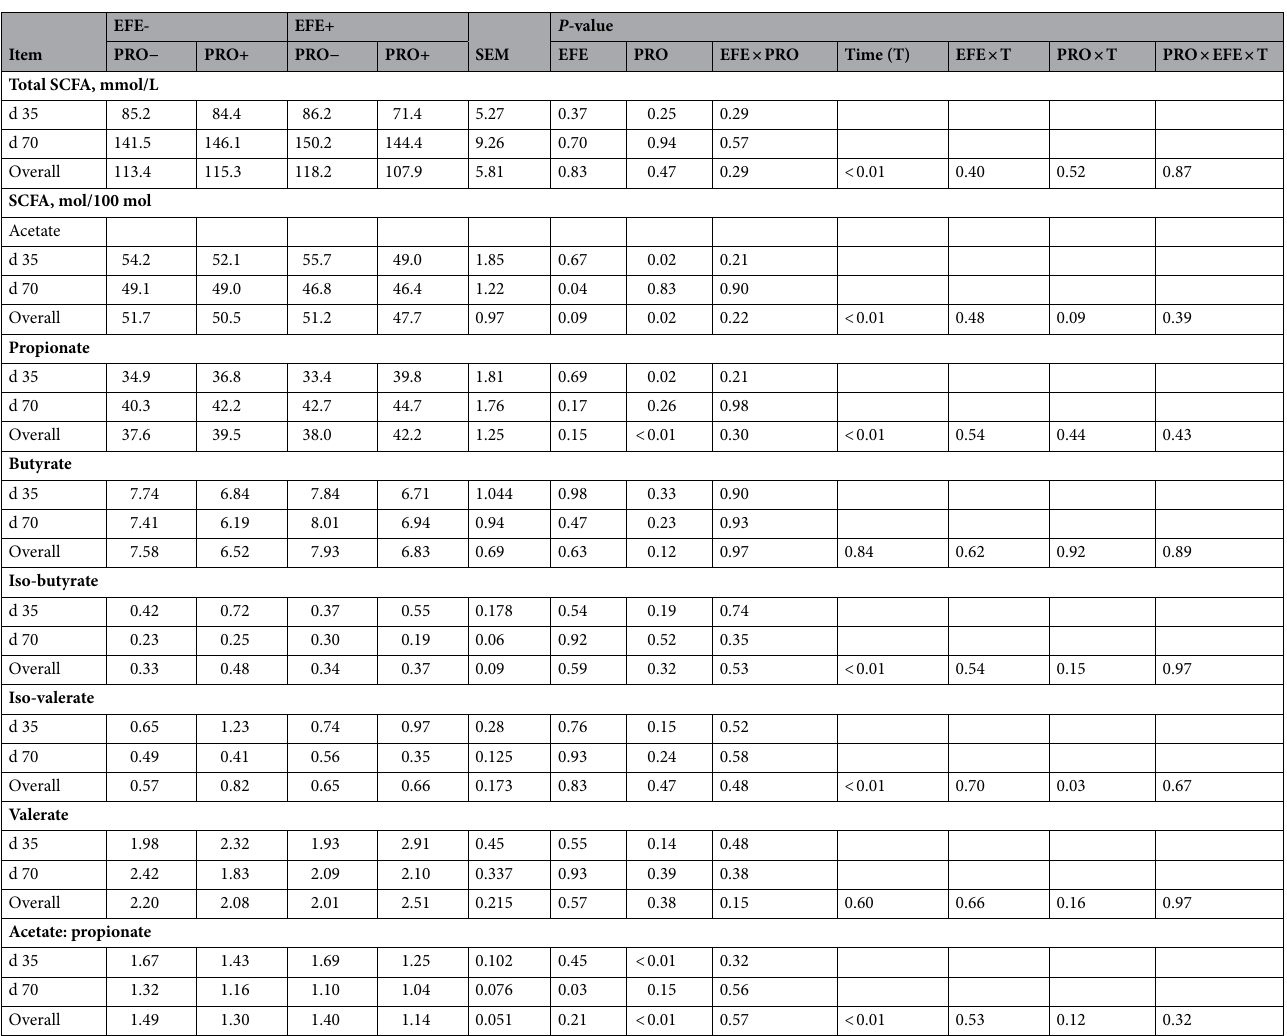
Table 7. Least squares means for ruminal fermentation in dairy calves supplemented with or without exogenous fibrolytic enzymes (EFE) and probiotic (PRO) in the starter diets (n = 12 calves per treatment). Treatments were (1) calves fed diets without exogenous fibrolytic enzymes (EFE)-treated wheat straw and probiotic supplement (EFE-Pro−), (2) calves fed diets of EFE-treated wheat straw but with probiotic supplement (2 g/d/calf; EFE-Pro+), (3) calves fed EFE-treated wheat straw (2 g/d/calf) but without probiotic supplement (EFE+ Pro−), (4) calves fed EFE-treated wheat straw and probiotic supplement (EFE+ Pro+). Exogenous fibrolytic enzymes were applied to wheat